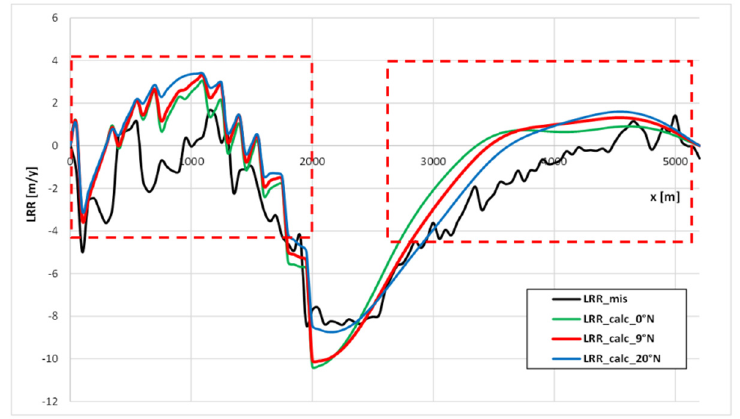
Figure 15. LRR functions for the three best equivalent directions (0° N, 9° N, and 20° N) compared with the LRR measured function of the Trigno area. Red dashed boxes indicate the two subareas where an overestimation was observed: the left one (first 2 km) was located within the groin area, while the second one was located within the unprotected zone (last 3 km).